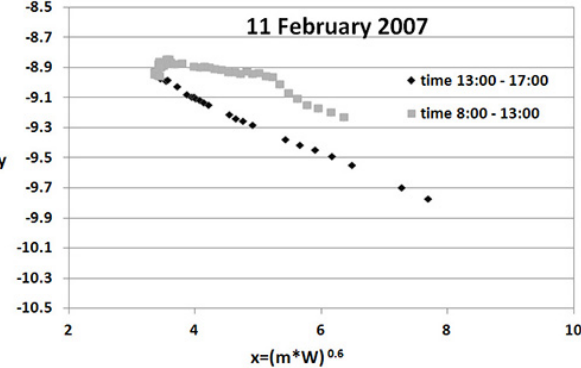
Fig. 3. Example of the application of type-2 modified Langley plot during winter time. The x value is calculated for a fixed indicative b = 0 . 6 (as suggested by Halthore et al., 1997, for narrow band fil-